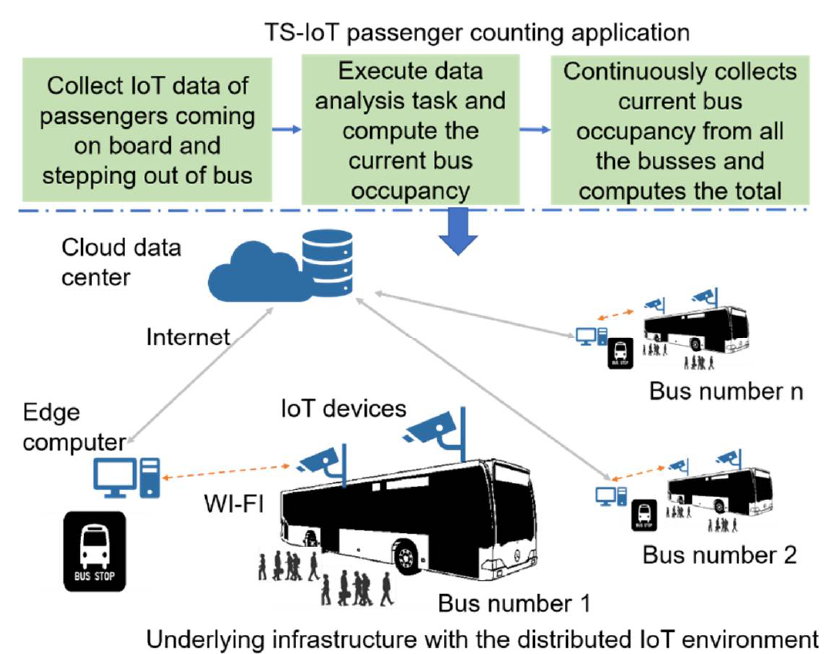
Figure 1. Illustration of motivating scenario.